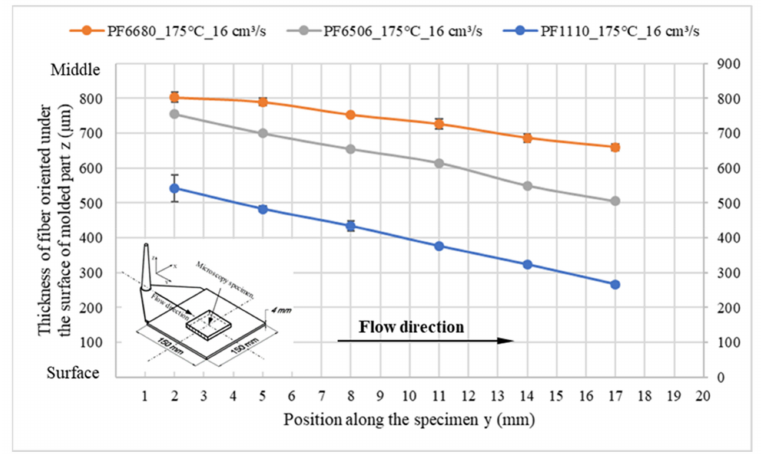
Figure 13. Influence of wall slip on the thickness of fiber oriented under the surface of the molded part.